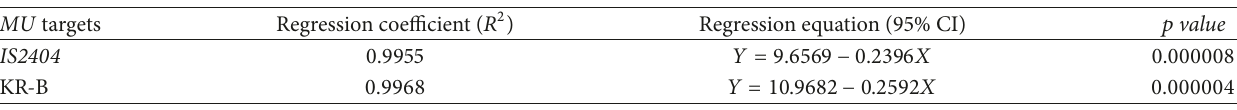
Table 5: Characteristics of the standard curves linking “Ct” values of MU targets and corresponding bacterial loads ( MU Agy99 serial